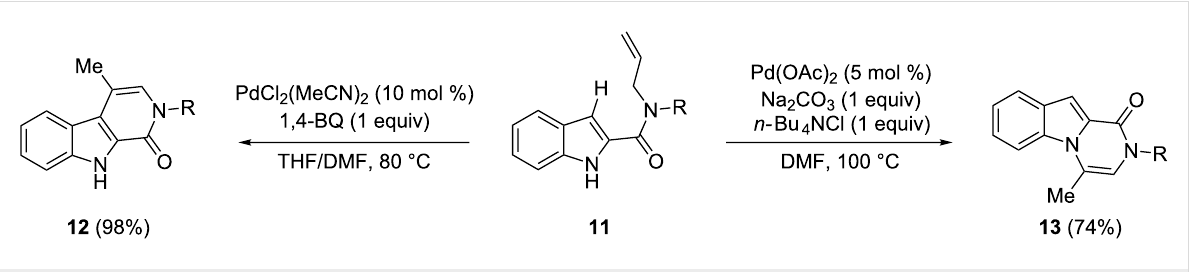
Scheme 11: Chemoselective cyclization of N -allyl-1 H -indole-2-carboxamide derivatives.